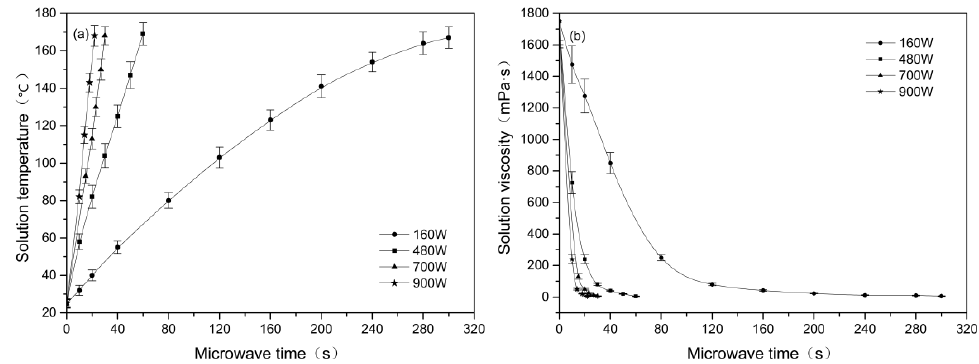
Figure 2. Effect of microwave power and time on the ( a ) temperature and ( b ) viscosity of the alkali/glycerin solutions. All solutions have an alkali concentration of 8 wt %.